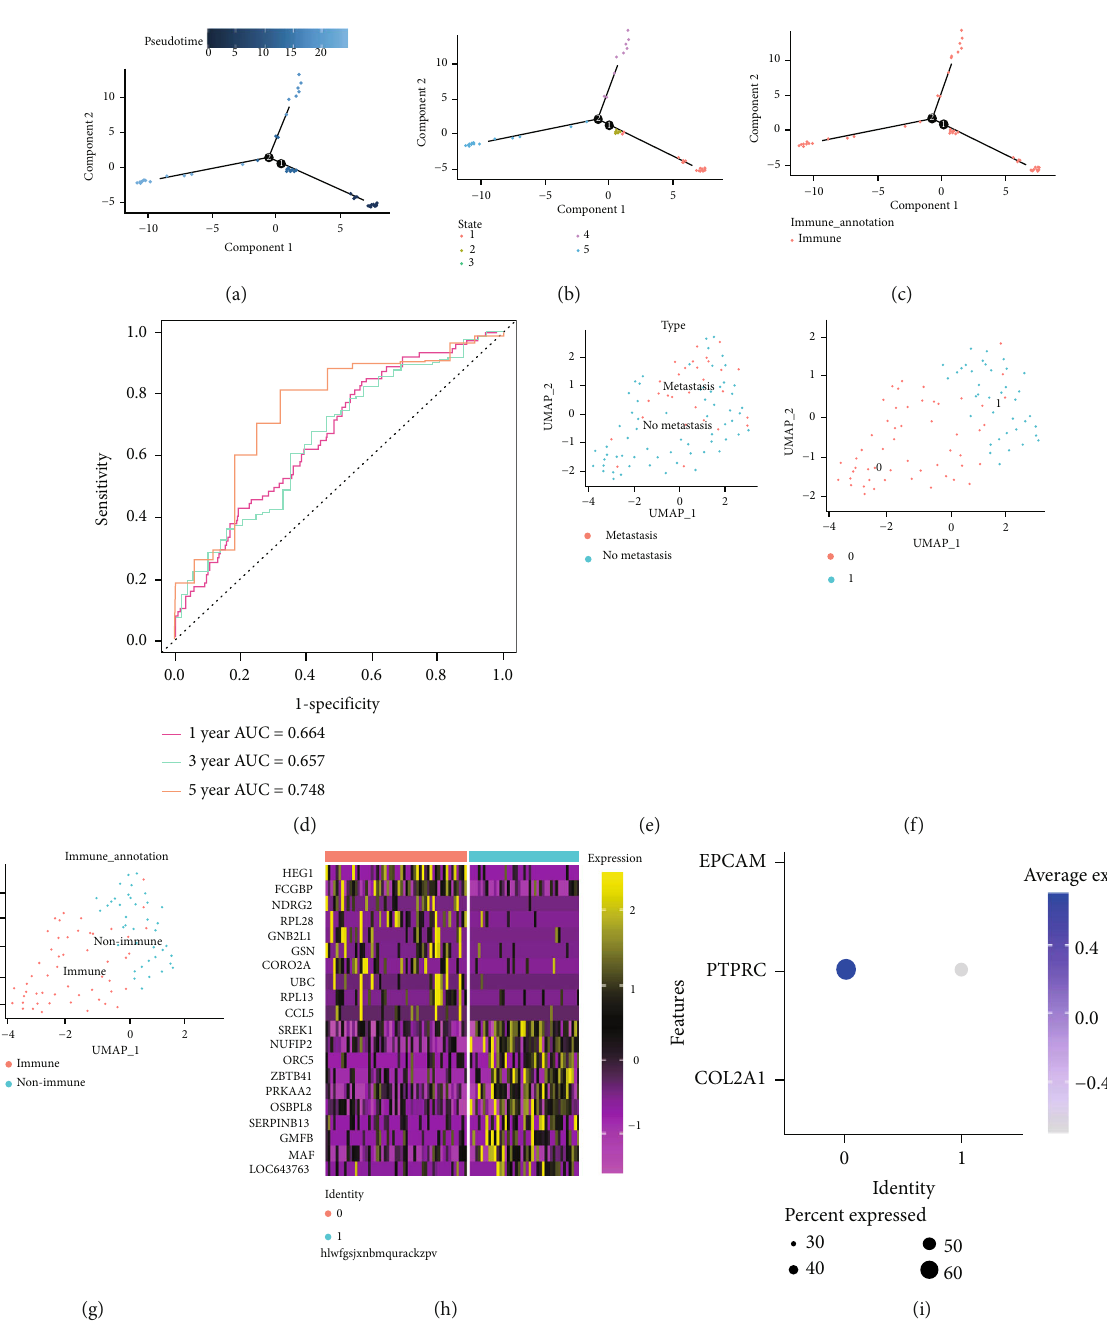
Figure 2: Dimensionality reduction clustering and pseudotime series analysis. (a) Spatial distribution of metastatic and nonmetastatic gastric cancer cells. It can be seen that gastric cancer cells are well divided into metastatic and nonmetastatic clusters. (b) Expression of immune cell markers in 2 clusters. (c) Spatial distribution of cluster1 and cluster0. (d) Spatial distribution of immune cells and nonimmune cells. (e) Heat map of the distribution of the top 10 di ff erential genes in the two clusters. (f) Pseudotime series analysis. Gastric cancer-immune cells di ff erentiate from the deeper blue to the lighter blue. (g) There are 5 states of gastric cancer-immune cell di ff erentiation. (h) The cells analyzed are all gastric cancer-immune cells. (i) The di ff erentiation track of metastatic gastric cancer- immune cells and nonmetastatic gastric cancer-immune